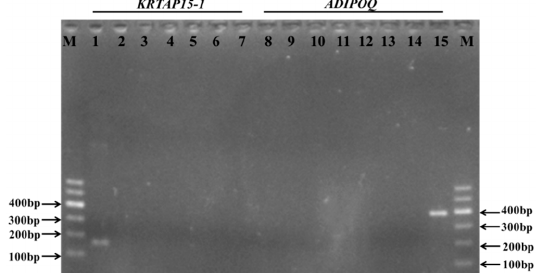
Figure 7. Polymerase chain reaction amplification of keratin-associated protein 15-1 gene and ADIPOQ using complementary deoxyribonucleic acid samples derived using reverse transcriptase from ribonucleic acid from seven tissues obtained from Gansu Alpine Fine-wool sheep. M: 100 bp deoxyribonucleic acid ladder; lanes 1 and 8: skin; lanes 2 and 9: heart; lanes 3 and 10: liver; lanes 4 and 11: spleen; lanes 5 and 12: lung; lanes 6 and 13: kidney; lanes 7 and 14: longissimus dorsi muscle; lane 15: positive control using a sheep genomic DNA sample.